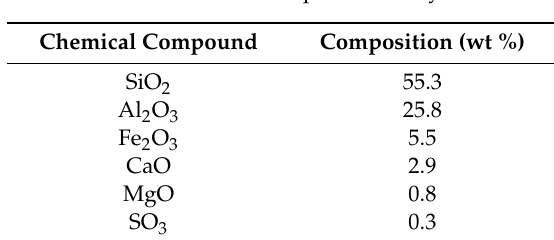
Table 2. Chemical composition of fly